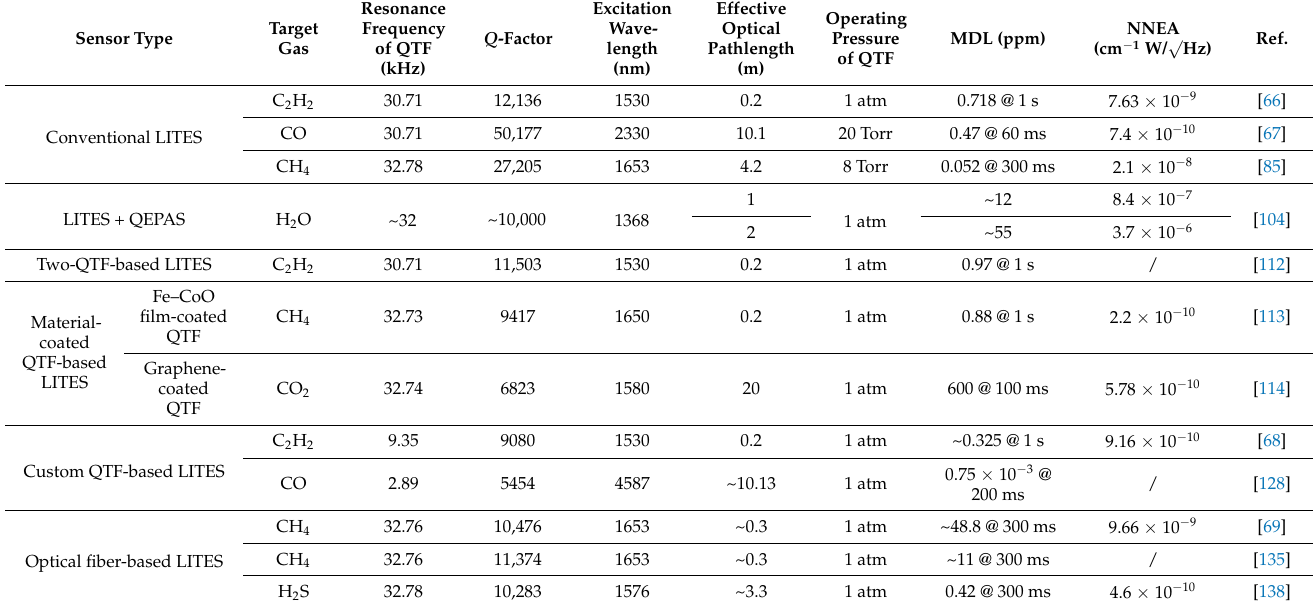
Table 2. The detection performance of the six types of LITES sensors in this review. atm: atmospheric